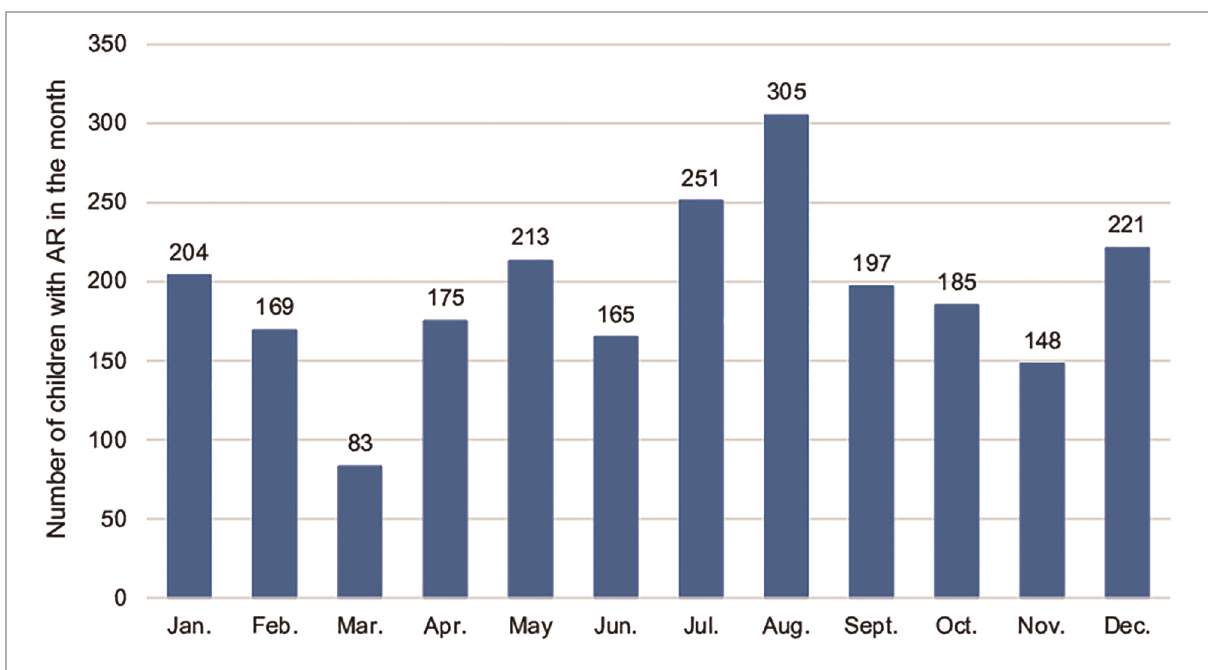
FIGURE 3 Distribution of cases of children with AR in different months. The abscissa represents different months, and the ordinate represents the number of children with AR.